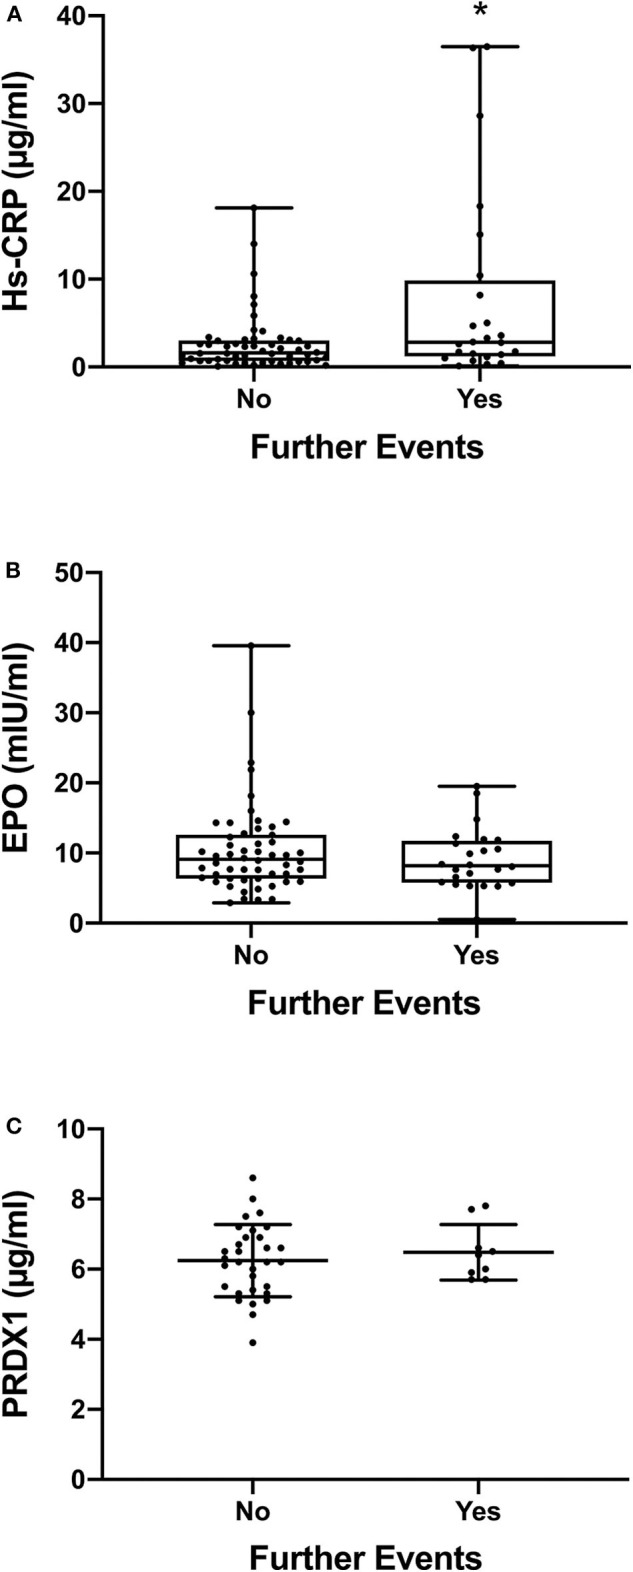
CRP, EPO, and PRDX1 levels in patients. Since the plasma levels of hs-CRP and EPO are not normally distributed, the data in (A,B) are presented as box and whiskers plot (minimum, 1st quartile, median, 3rd quartile, maximum); n = 54 for the group with no further events and n = 24 for the group with further events. The plasma levels of PRDX1 are normally distributed and therefore the data in (C) are presented as mean ± SD; n = 31 for no further events and n = 9 for further events. In all panels, each dot indicates individual data from each subject. *P < 0.05 by Mann-Whitney U-test. No significant difference between the two groups of data was detected in (B,C) by Mann-Whitney U-test and Student's t-test, respectively.